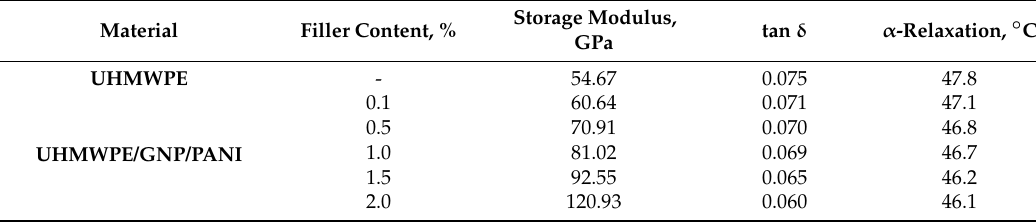
Figure 9. DMA dynamic storage modulus of the UHMWPE/GNP/PANI films. Table 4. Dynamical mechanical properties of the UHMWPE/GNP/PANI films at room temperature and the α -relaxation temperature evaluated at the maximum peaks of the loss modulus